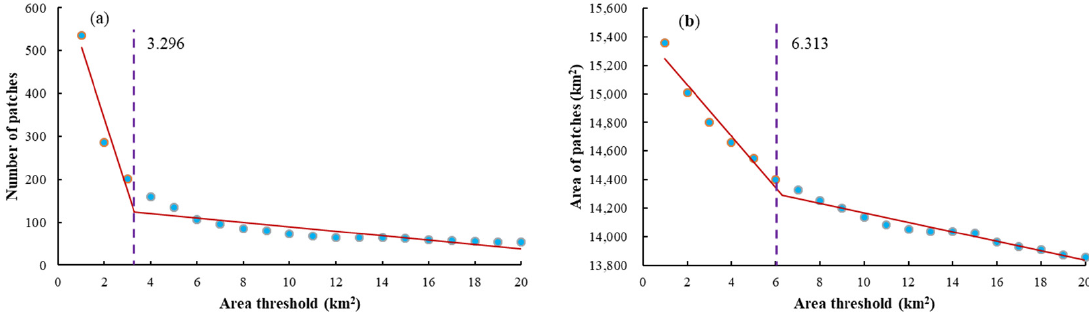
Figure A2. Number ( a ) and area ( b ) of ecological sources under different area thresholds in 2010.